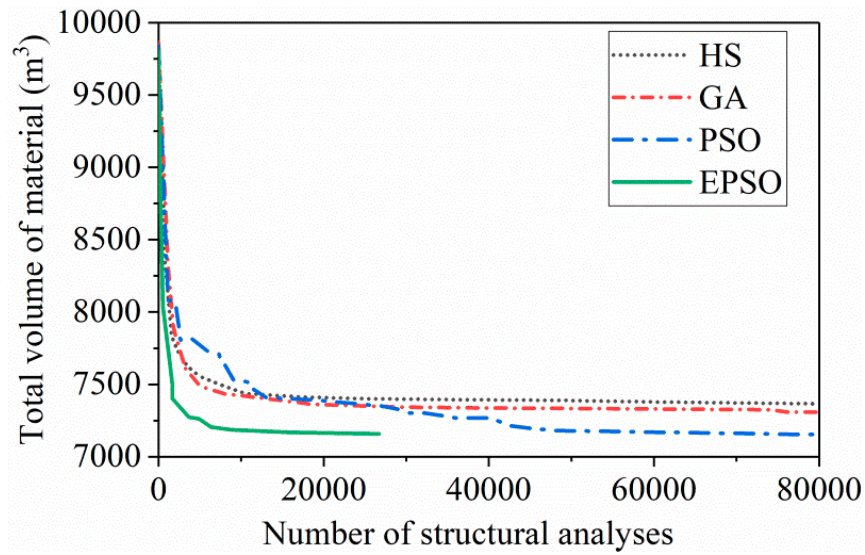
Figure 3. Comparison of different optimization approaches.